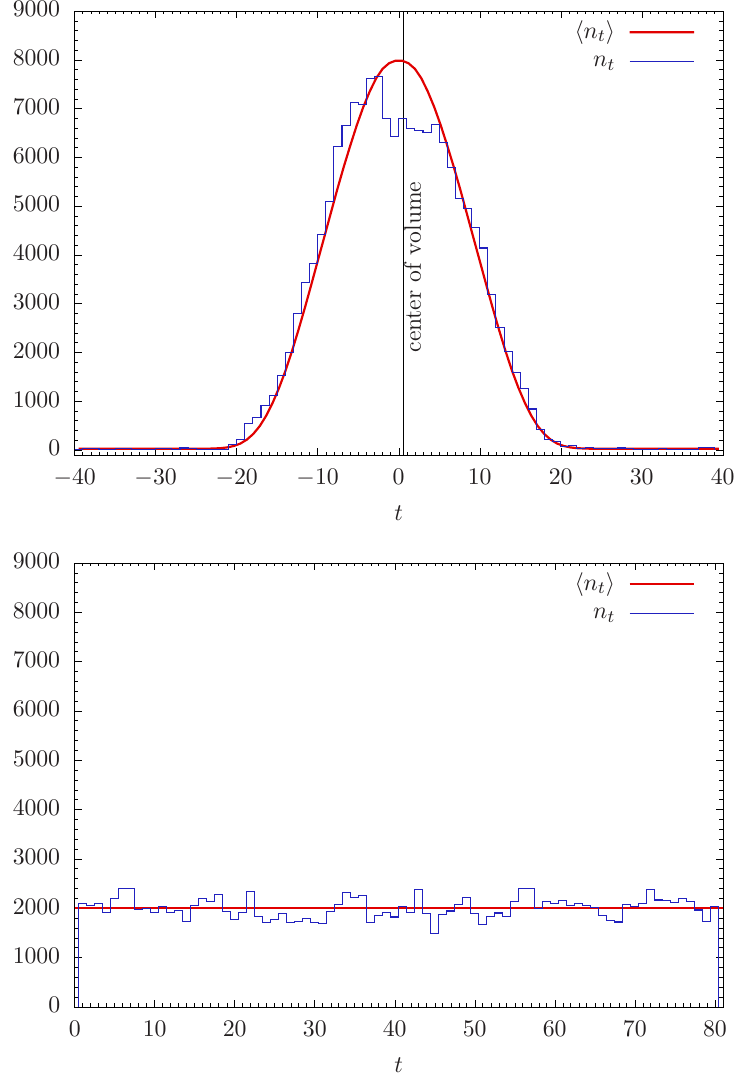
Figure 6. The average (red) and typical (blue) volume profiles for spherical spatial topology ( top figure) and for toroidal spatial topology ( bottom figure) in the C dS phase. In both cases, the time direction has length T = 80 (in lattice units) with periodic boundary